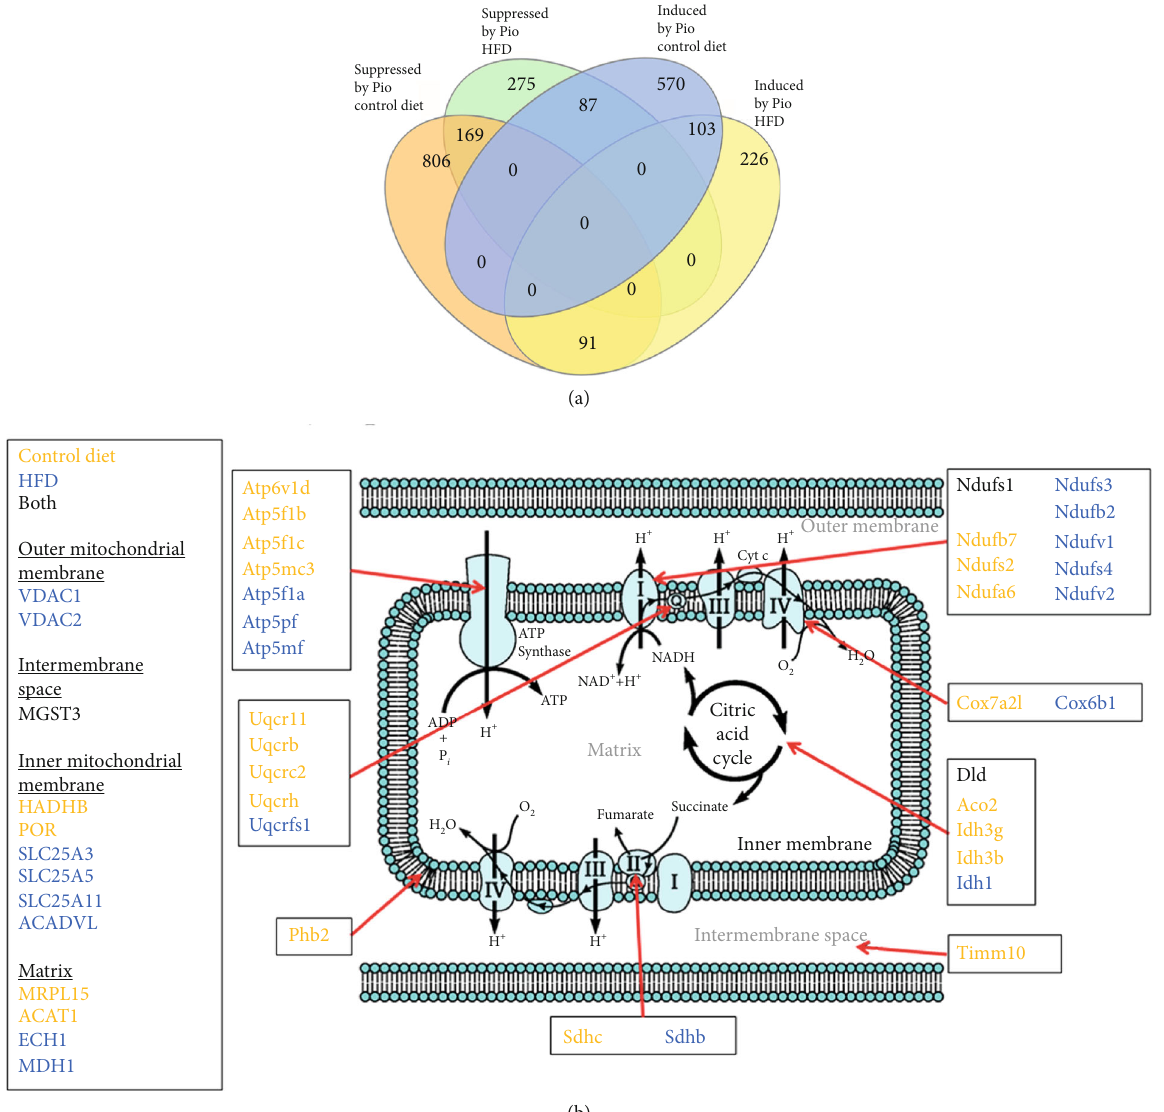
Figure 6: BETA Analyses of Pio ’ s E ff ects on Mitochondrial Gene Expression - (a) Venn diagram analysis depicting genes identi fi ed by BETA as most likely to be regulated by Pio-induced e ff ects on liver RXR-DNA binding in WT mice on control versus HFD. (Input RXR-liver DNA binding data from the KO mice was insu ffi cient to execute BETA.) (b) Nuclear genes encoding mitochondrial proteins identi fi ed by BETA as likely to be Pio-induced by PPAR γ -dependent e ff ects on liver RXR-DNA binding (genes in orange were identi fi ed from analyses of mice on control diet; those in blue from analyses of mice on HFD; and those in black from analyses of mice on either diet). ∗ The mitochondria illustration is adapted from an image freely available in the public domain at https://commons.wikimedia.org/wiki/File:Mitochondrial_